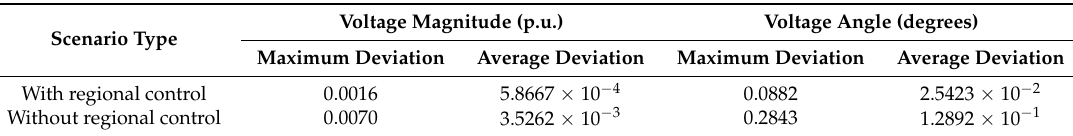
Figure 5. Voltage angle bounds in modified IEEE 33-bus distribution system. Table 1. Deviation analysis under different scenarios.